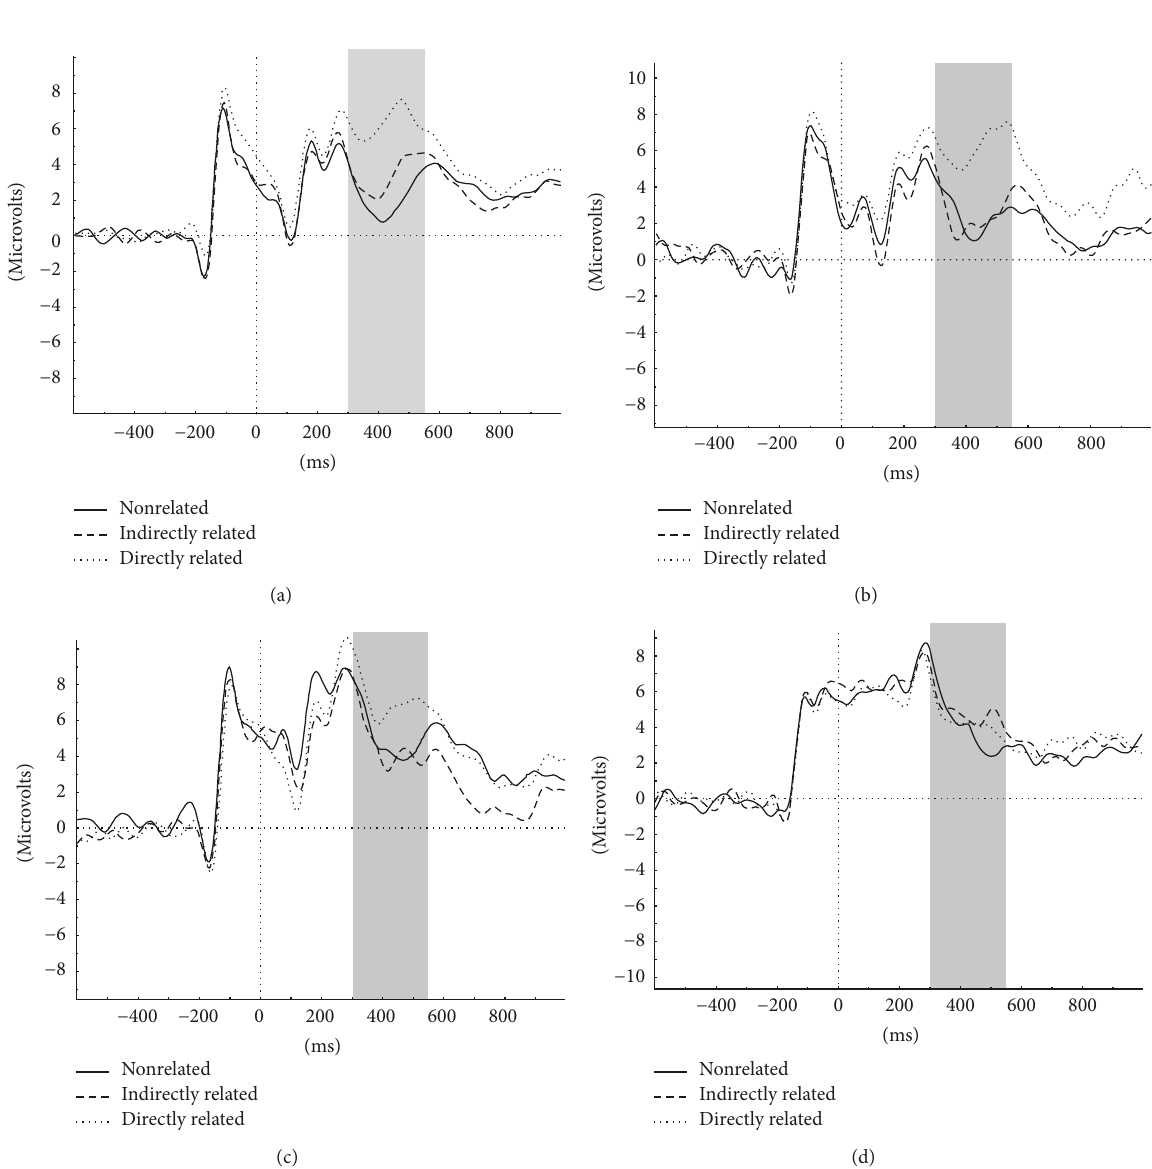
Figure 3: Grand-averaged EEG waveforms at the Cz electrode depicting the course of the ERPs across the three conditions and the four monozygotic twin groups: (a) concordant healthy, (b) discordant unaffected, (c) discordant affected, and (d) concordant